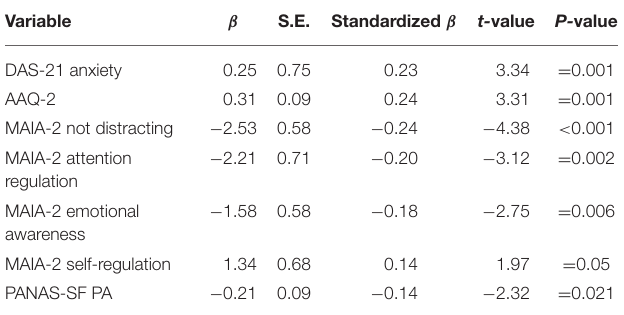
FIGURE 4 | The mediated relationship, where emotional regulation interoception ( x ) predicts alexithymia total ( y ) and self as context (SAC, M i )